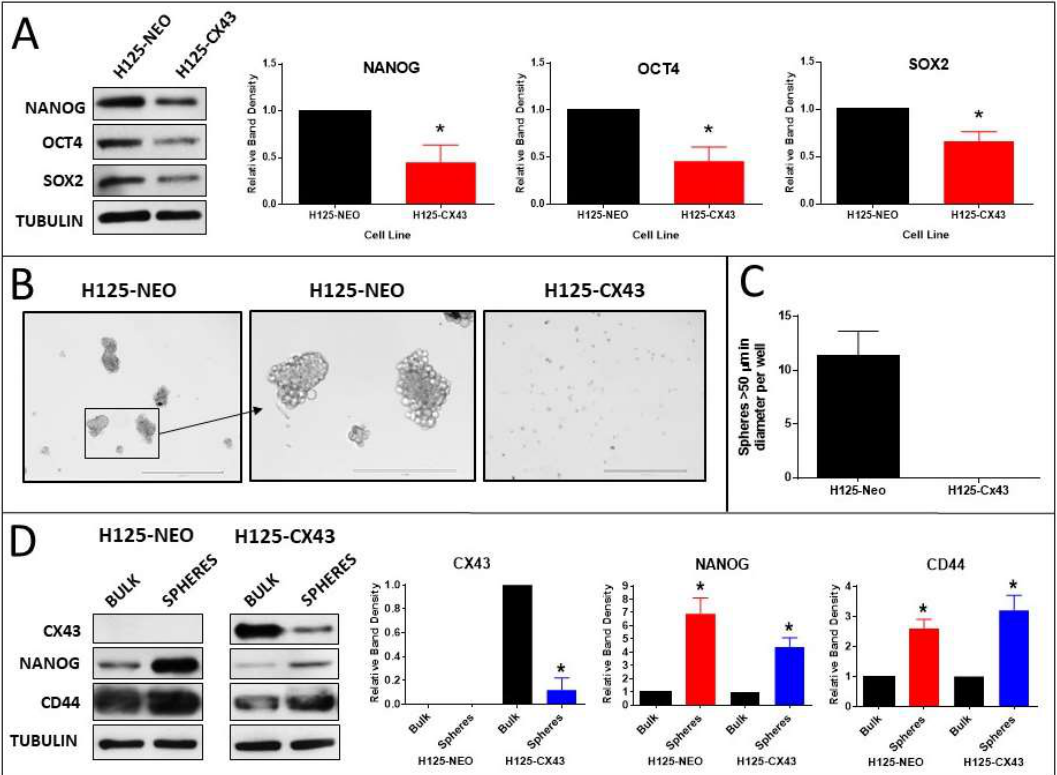
Figure 6. Connexin43 suppresses the expression of stem cell pluripotency markers and tumorsphere formation. ( A ) Western blots of stem cell pluripotency factors Nanog, Oct4, and Sox2 in H125-NEO and H125-CX43 cells; band densities were normalized to tubulin loading control and to H125-NEO (* p < 0.01 compared to H125-NEO, one-sample t-test, mean ± S.D., n = 3 replicate experiments); ( B ) images of tumorspheres after 3 weeks culture in stem cell medium; scale bars: 1000 µ m (left and right panels) and 400 µ m (middle panel); ( C ) quantification of spheres larger than 50 µ m in diameter (mean ± S.D., n = 3 replicate experiments); ( D ) Western blots of Cx43, Nanog, and CD44 in bulk cells and spheres; band densities were normalized to tubulin loading control and to bulk cells (* p < 0.01 compared to bulk cells, one-sample t -test, mean ± S.D., n = 3 replicate experiments).